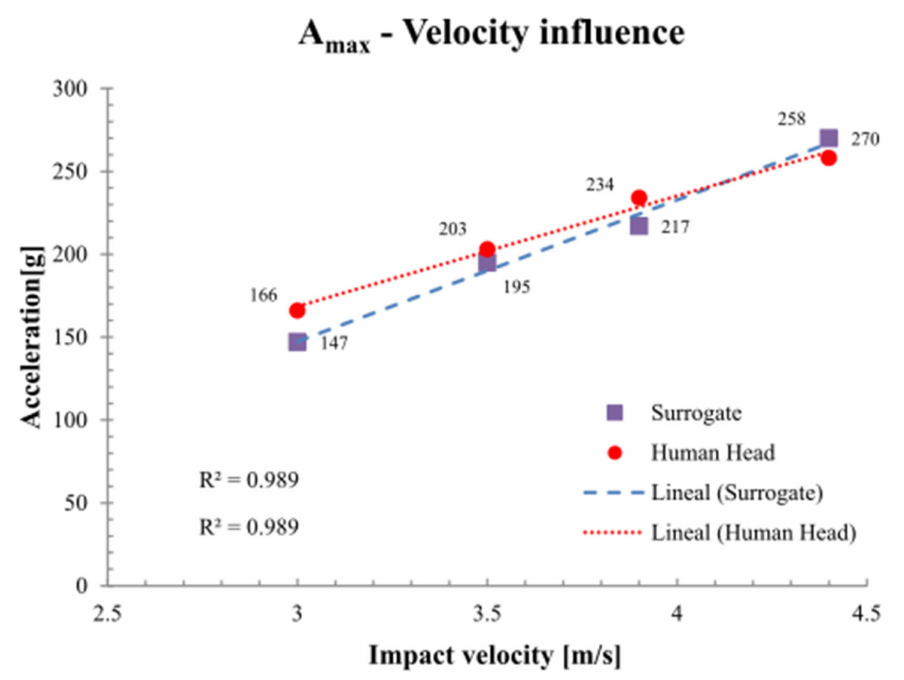
Figure 13. PLA at di ff erent frontal impact velocities for the human